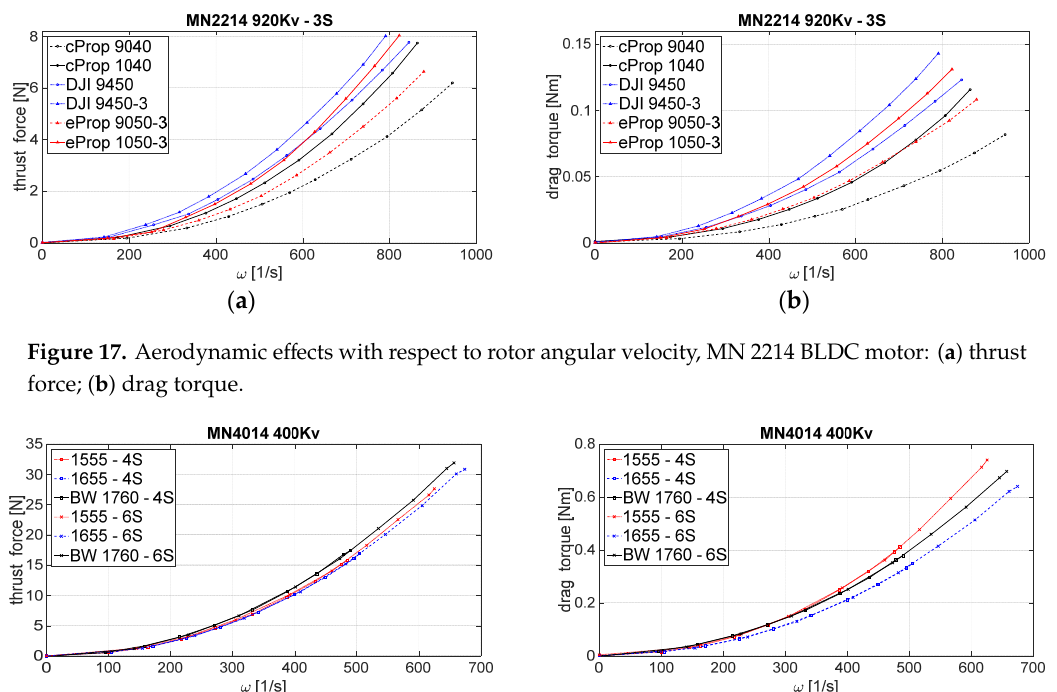
Figure 16. Aerodynamic effects with respect to rotor angular velocity, 1806 BLDC series: ( a ) thrust force; ( b ) drag torque.